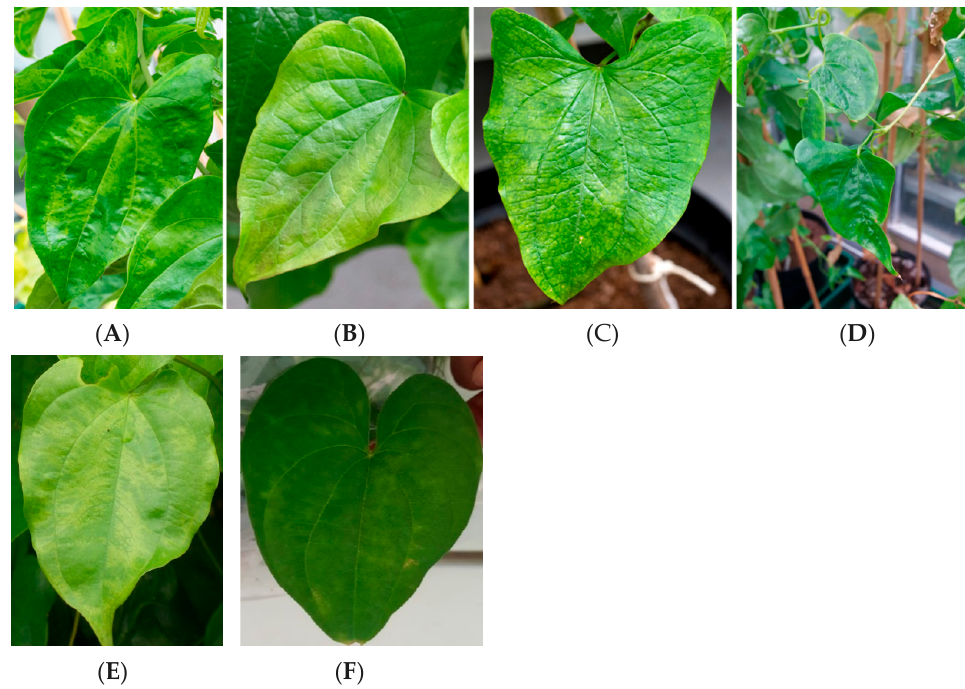
Figure 1. Typical virus symptoms on yam. ( A ) D. rotundata TDr 99/02674 showing mosaic symptoms; ( B ) D. rotundata cv. Adaka showing chlorotic leaf discoloration, and ( C ) mottling; ( D ) D. rotundata TDr 00/00168 showing leaf deformation (( A – D ) source G.R.E. Silva (NRI) [20]); ( E ) D. rotundata leaf discoloration (Source: Stephen Winter, DSMZ), ( F ) D. alata showing diffused mottling.